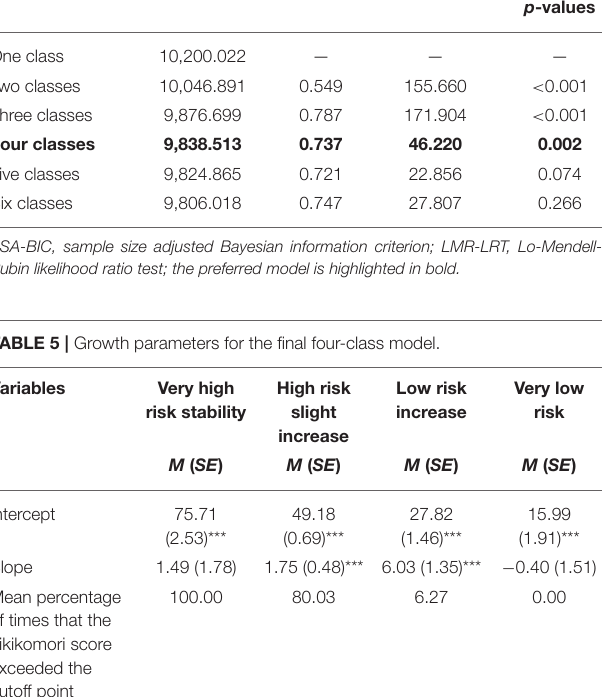
TABLE 3 | Bivariate correlations between predictors at T1 and hikikomori symptoms across T1–T3. Predictors at T1